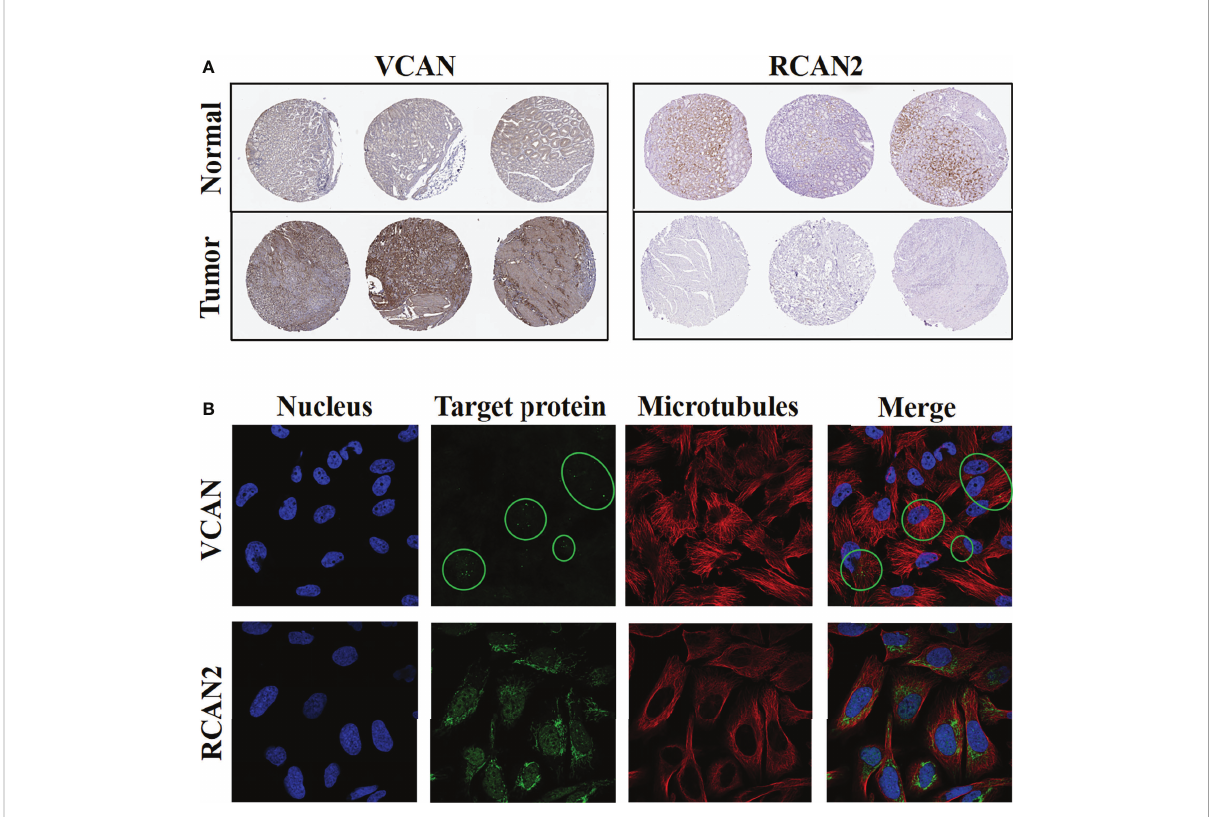
FIGURE 12 Protein expression levels and cellular spatial localization of VCAN and RCAN2. (A) Immunohistochemical experiments of VCAN and RCAN2 in gastric cancer and normal tissues. (B) The immuno fl uorescence experiments of HPA database showed that VCAN mainly exists in the vesicles of U-251 MG cells, and RCAN2 mainly exists in the mitochondria and nucleoplasm of U-2 OS